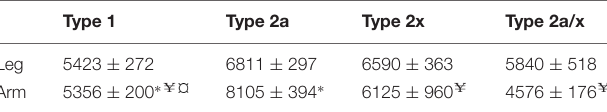
TABLE 4 | Fiber size in the arm ( triceps brachii ) and leg ( vastus lateralis ) muscles of elite cross-country skiers ( n =